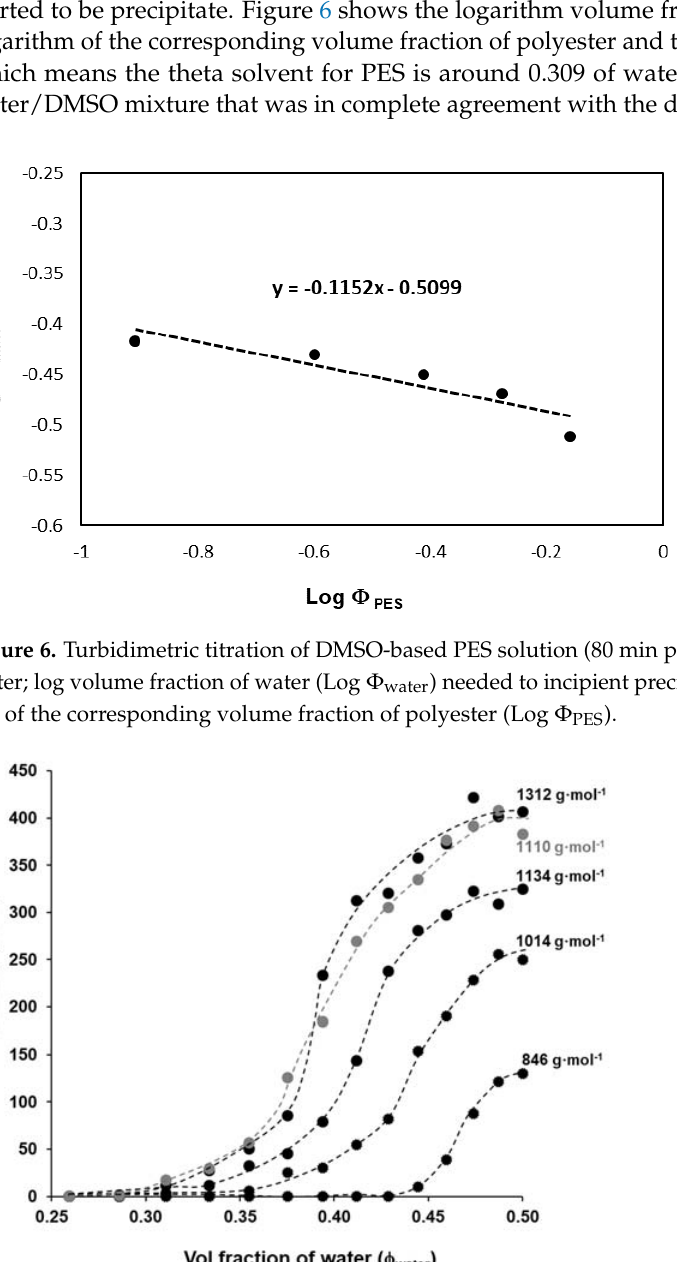
Figure 7. The precipitation curves of the synthesized polyester with increasing molecular weight as a function of water content in water/DMSO mixture (10 mL 1% DMSO based PES solution was precipitated by drop wise addition of distilled